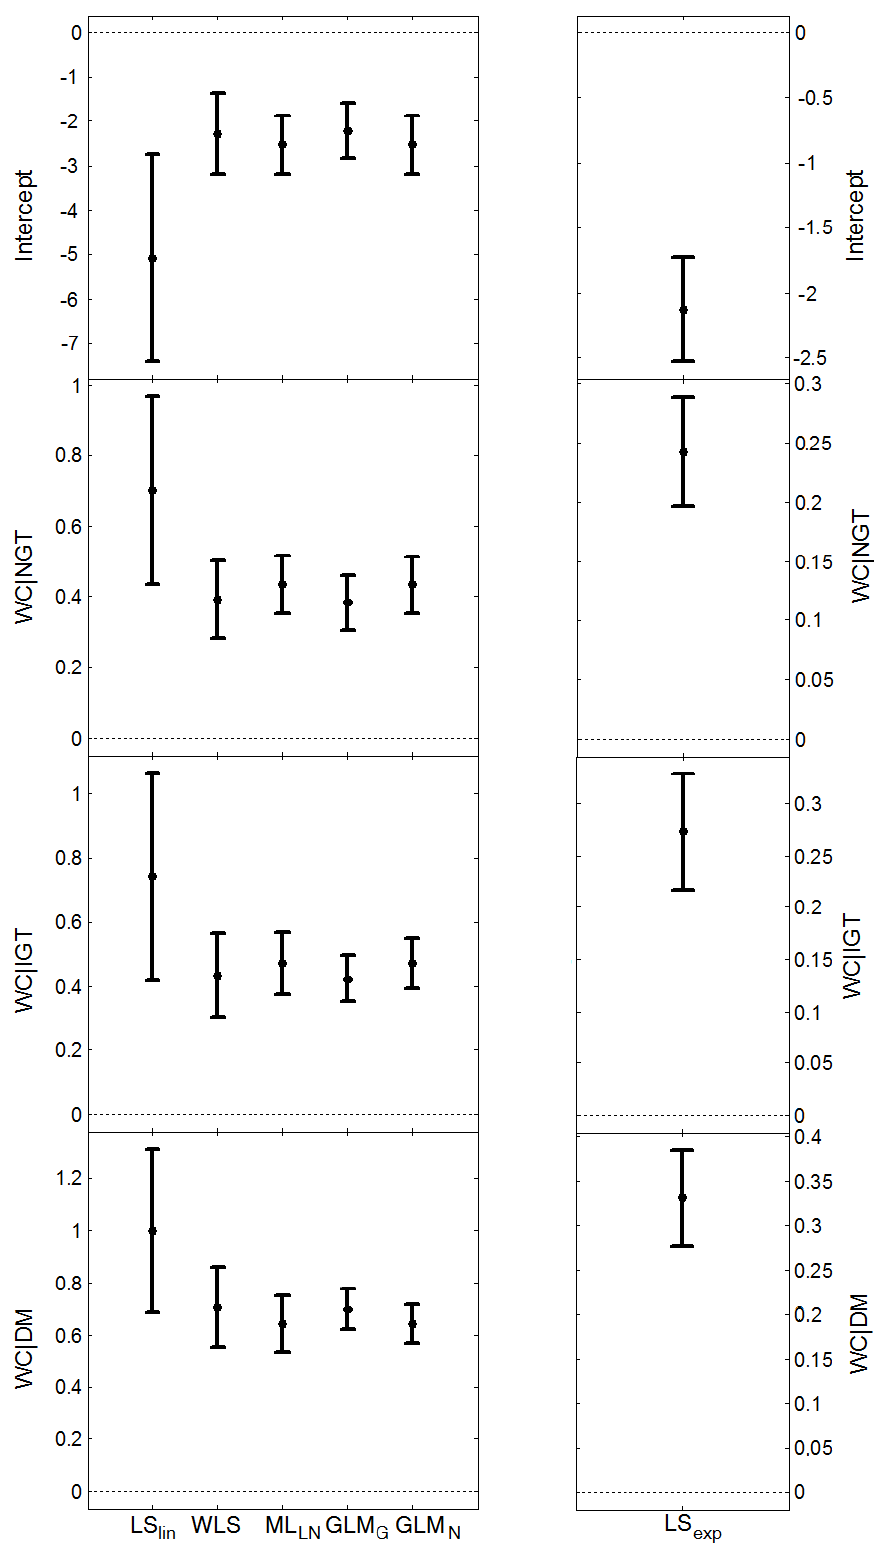
Figure 2. The parameter estimates and 95% confidence intervals for the different regression methods, when estimating HOMA-IR as a function of waist circumference (WC) and the interaction between WC and glucose tolerance group (normal glucose tolerance, impaired glucose tolerance and diabetes mellitus), using n = 598